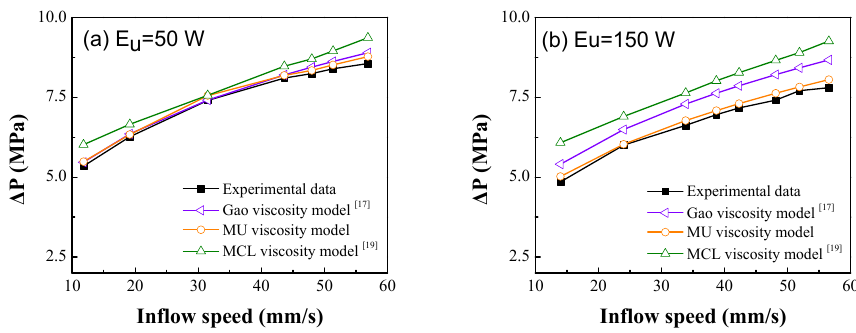
Figure 5. Pressure differences in ultrasonic microinjection at different inlet inflow speed ( a ) Ultrasonic vibration energy E U = 50 W; ( b ) Ultrasonic vibration energy E U = 150 W.